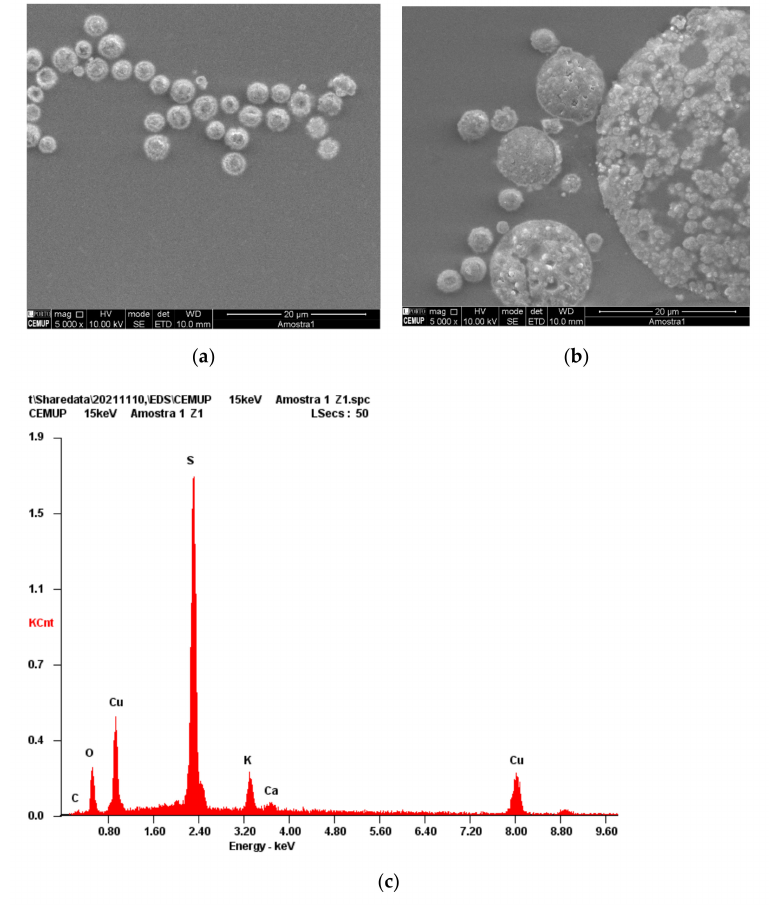
Figure 2. ( a , b ) SEM images of Cu-CD and ( c ) the corresponding